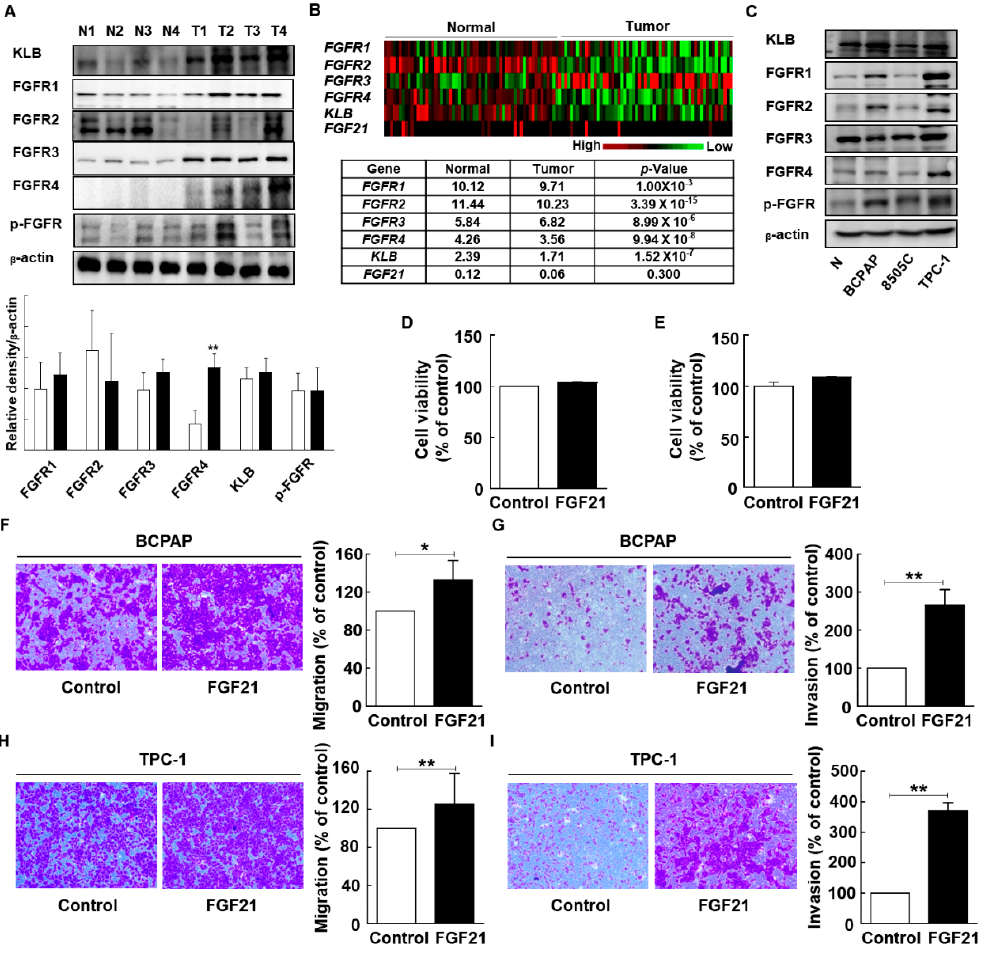
Figure 3. Expression of FGF receptors ( FGFRs ) in human thyroid tissue and the effects of FGF21 on the viability, migration, and invasion of thyroid carcinoma cells. ( A ) Western blot analyses of β -klotho (KLB) and FGFR protein levels in total cell lysates from paired clinical specimens of normal (N) and tumor (T) tissues from four patients with PTC (white bar, normal; black bar, tumor). ( B ) Gene expressions of FGFR1 , FGFR2 , FGFR3 , FGFR4 , KLB , and FGF21 between normal tissues and paired tumor tissues from genes and columns represent each patient.) ( C ) Protein expression of KLB and all FGFRs in